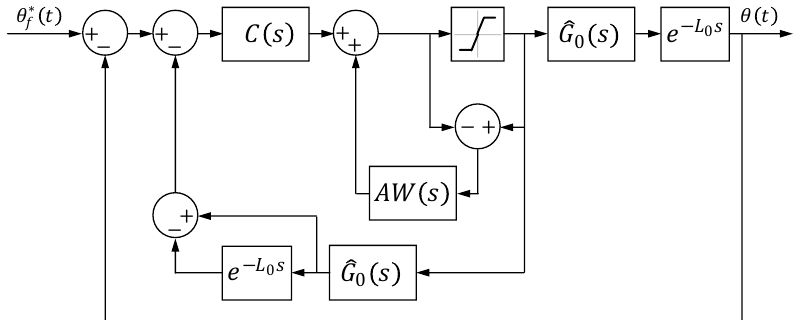
Figure 9. Smith predictor scheme.